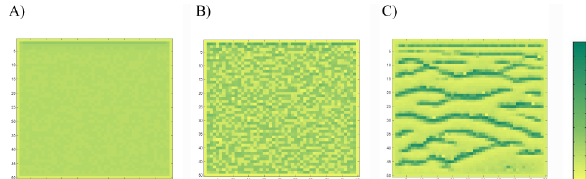
Fig. 17. Effect of hydraulic conductivity on pattern formation. (A) Uniform hydraulic conductivity. (B) Hydraulic conductivity randomly variable in space. (C) Hydraulic conductivity variable in space as a function of vegetation density.